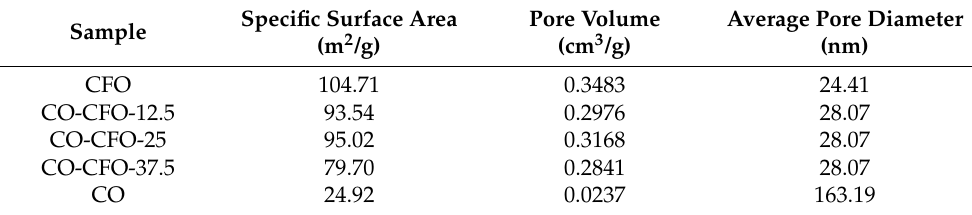
Table 1. The comparison of SSAs, pore volume, and average pore diameter of CFO, CO-CFO-X, CO.